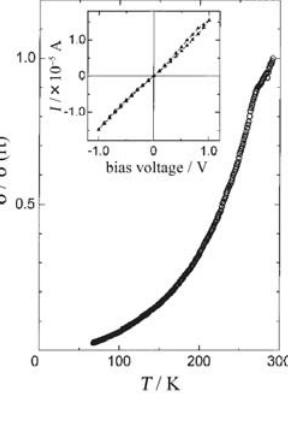
Figure 28. Temperature dependence of normalized conductivity in TTF • TCNQ